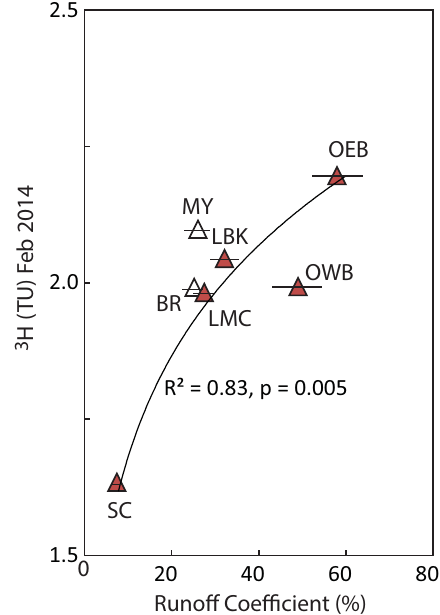
Figure 3. Runoff coefficient vs. 3 H activities for February 2014. Bars show range of runoff coefficients arising from the likely range of rainfall in the catchments, line is a logarithmic fit to the data that has an R 2 of 0.83. Open symbols are sampling sites on the main Ovens River, closed symbols are from the headwater tributaries. BR = Bright, LBK = Lower Buckland, LMC = Lower Morses Creek, OEB = Ovens East Branch, OWB = Ovens West Branch, SC = Simmons Creek. Data from Tables 1 and 2; precision of 3 H activities (Table 1) is approximately the size of the